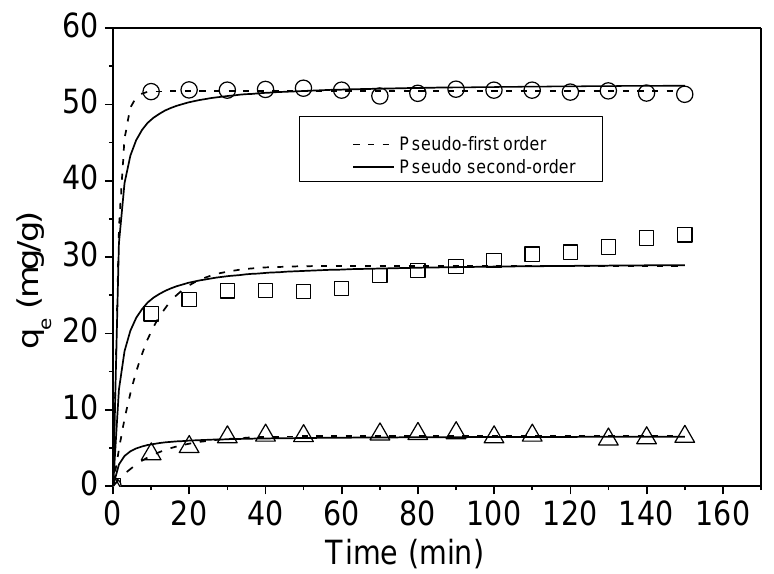
Figure 8. Adsorption kinetics: effect of contact time of removal of OG dye by (o) B-Act-CTAB300, (□) B - CTAB and (Δ) B -Act-CTAB100. Conditions: dye concentration 50 mg/L; adsorbent dosage m s = 1 g/L; pH = 6; T = 298 ± 1 K. Continuous and dashed lines correspond to fits of the experimental data.